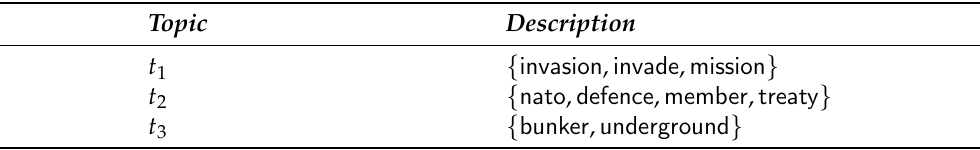
Table 3. Some examples of the topics and their descriptions extracted by BERTopic.